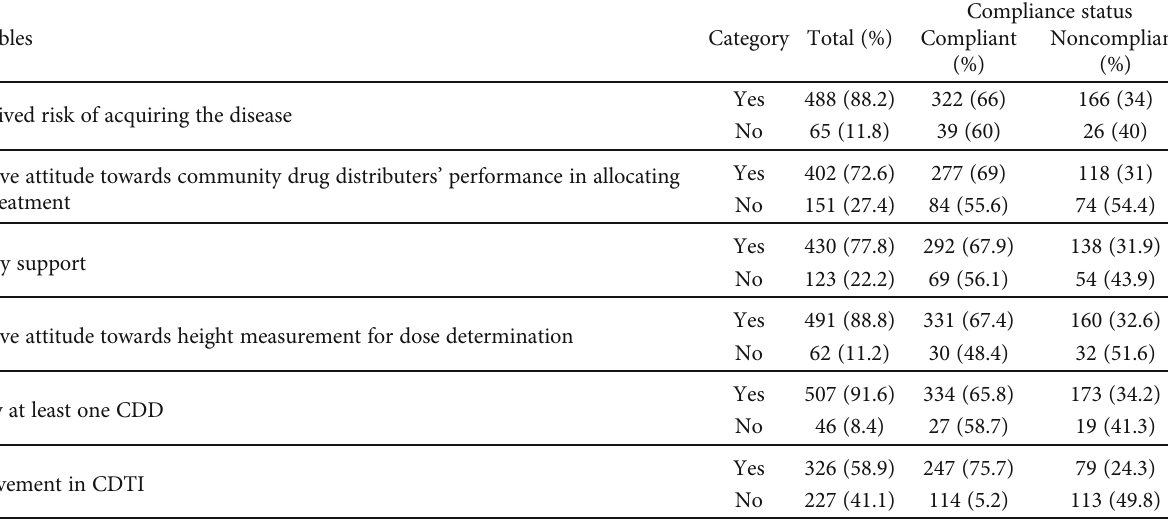
Table 3: Behavioral and individual characteristics of the study participants in the Semen Bench District, Bench Maji Zone, Southwest Ethiopia, June 2018 ð n = 553 Þ